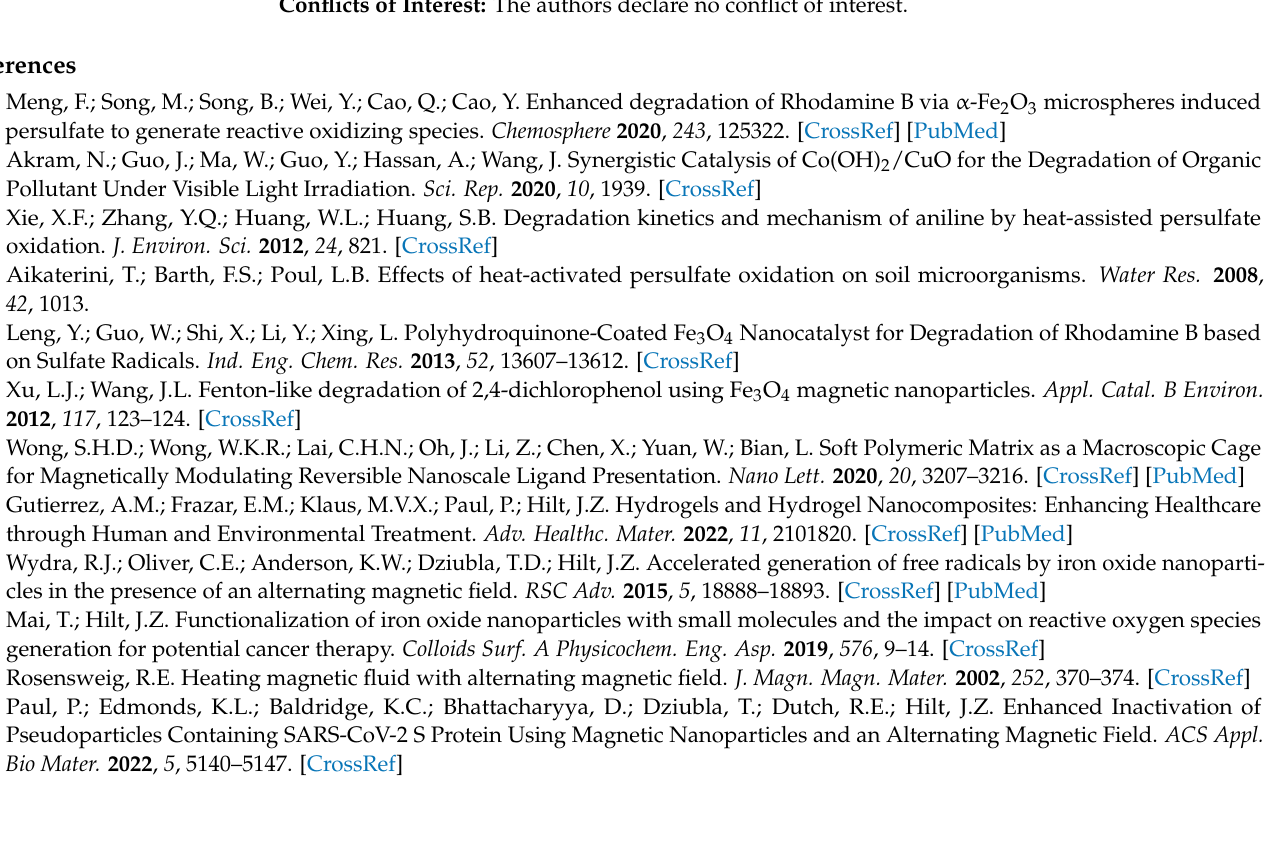
Figure S2: Heating profile of IONP-acrylamide magnetic nanocomposites exposed to AMF. (a) For 3% MNPs in varying AMF strengths; (b) for 34.13 kA/m strength AMF with varying MNP concentrations in nanocomposites. The temperature profile of 0 kA/m exposure and 0% MNP nanocomposite exposed to 34.13 kA/m respectively in (a) and (b) is decreasing with time due to the AMF chiller. This demonstrates that the heating in these two samples is insignificant compared to the chilling by AMF chiller. Figure S3: Arrhenius plots derived from pseudo-first-order kinetic model